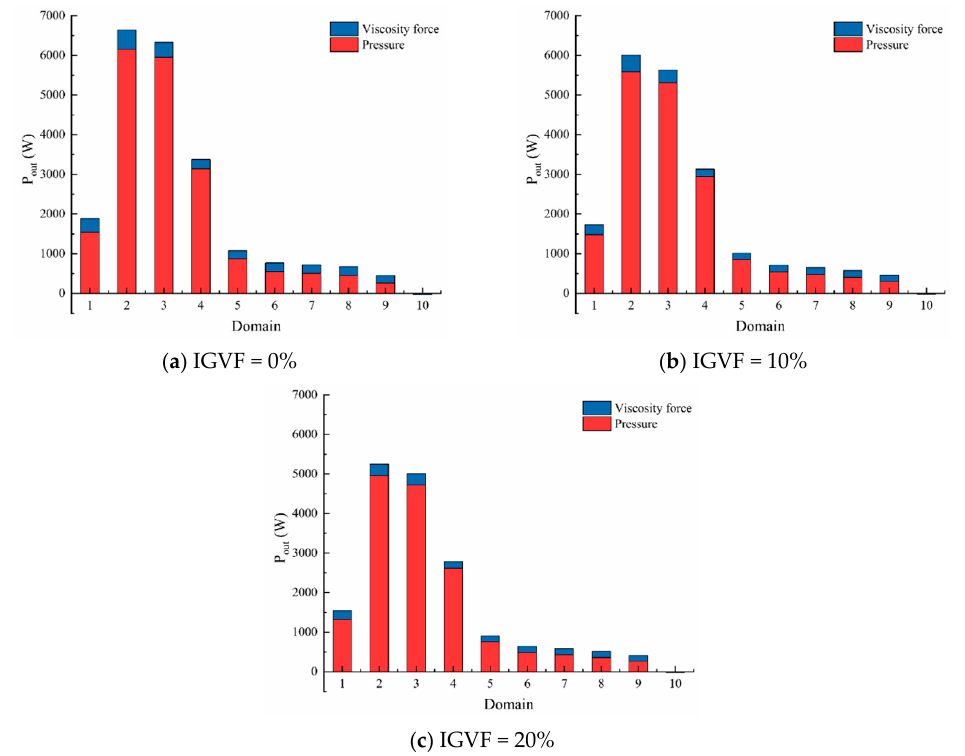
Figure 10. The distribution of the output power within each fluid domain under different IGVFs at the critical cavitation stage.